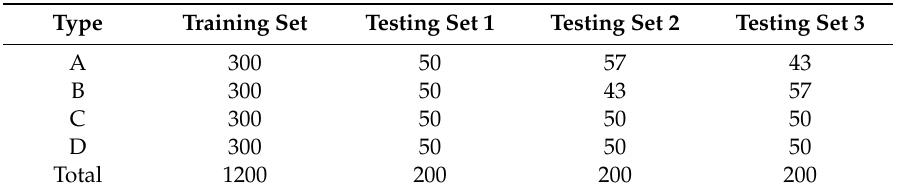
Table 4. Data allocation of training set and testing sets.